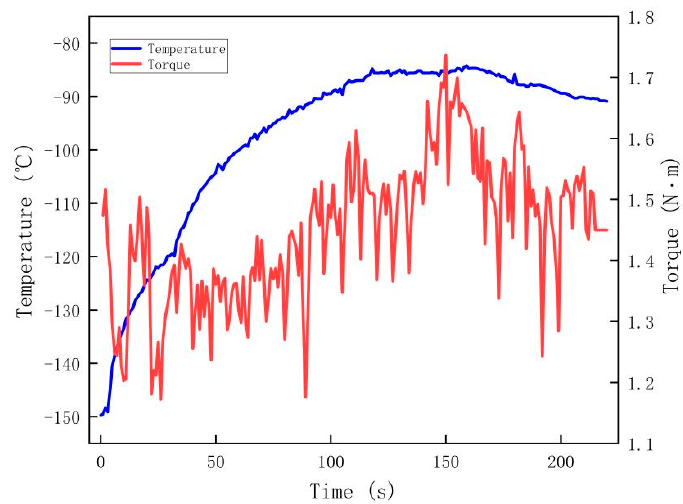
Figure 6. Torque and temperature curves of No. A1.